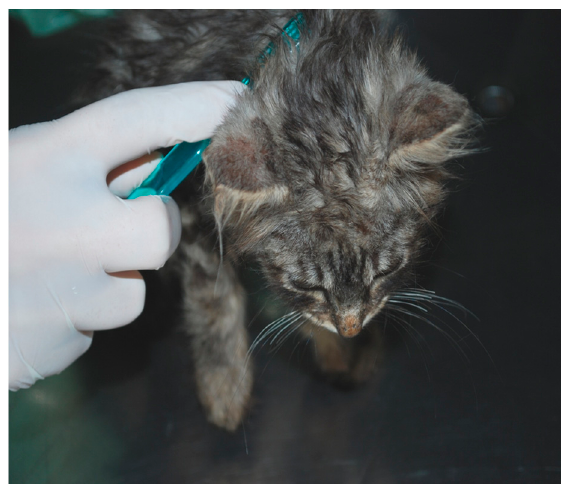
Figure 3. A kitten infected by M. canis (source of infection in case # 1) with no evidence of clinical lesions, sampled by the tooth-brush technique.